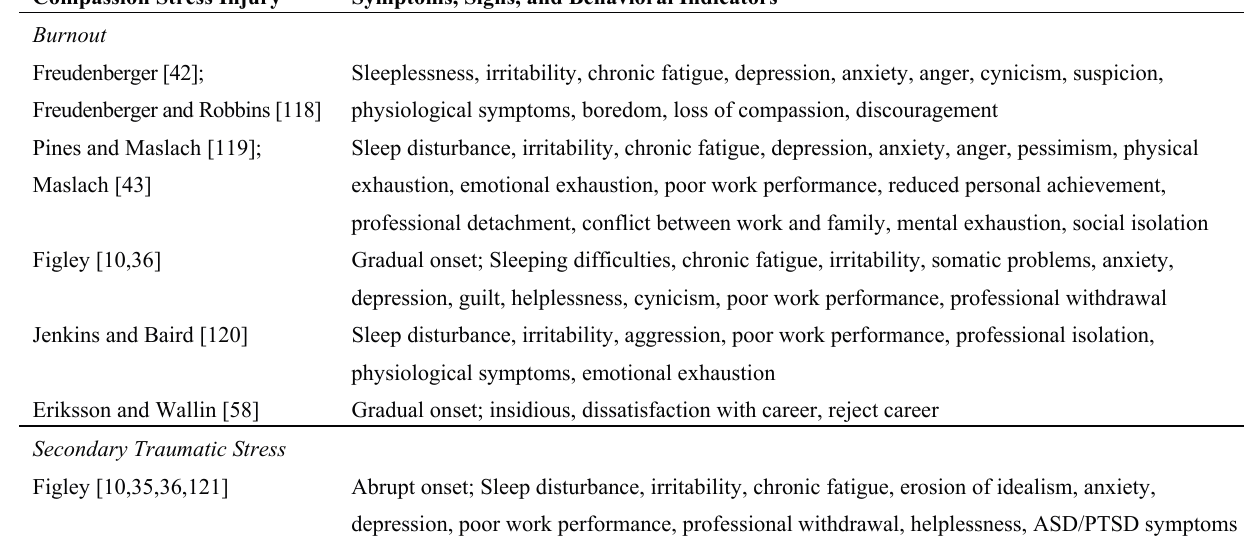
Table A1. Comparison of Symptoms, Signs, and Behavioral Indicators for